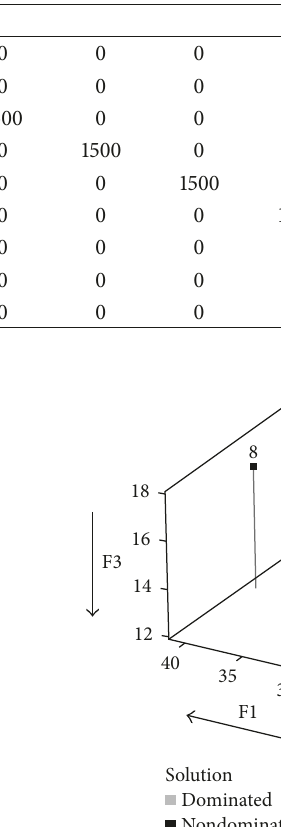
Table 8: Matrix S to evaluate the second condition of Pareto.